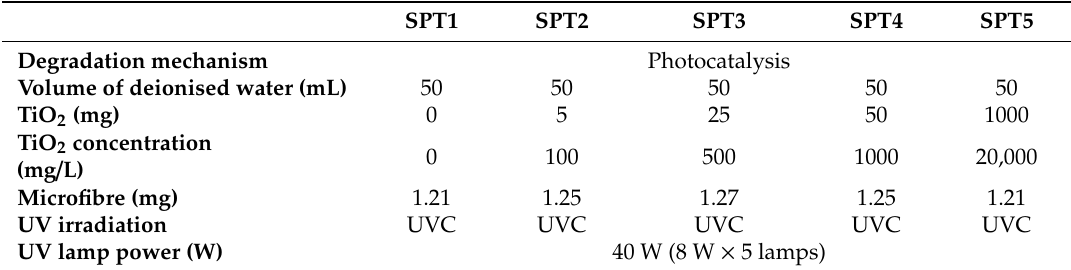
Table 2. Summary of the set-up for SP1-SP5 investigating the optimal concentration of TiO 2 under UVC. Each condition was studied in triplicate. SPT1 SPT2 SPT3 SPT4 SPT5 Degradation mechanism Photocatalysis Volume of deionised water (mL) 50 50 50 50 TiO 2